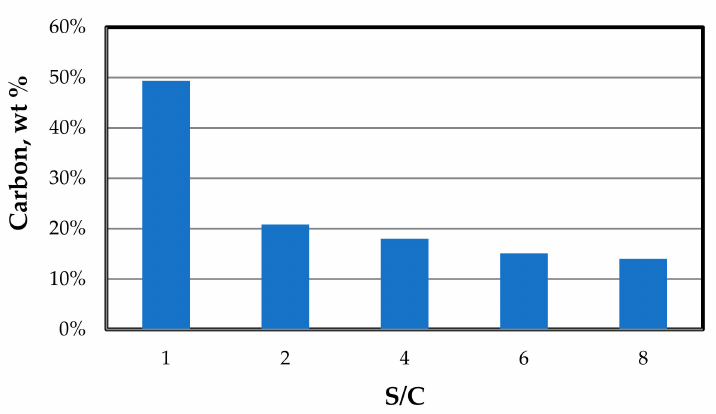
Figure 12. Amount of carbon deposited on the surface of the catalyst during the steam reforming reaction of toluene at 600 ◦ C for different values of the S/C ratio.